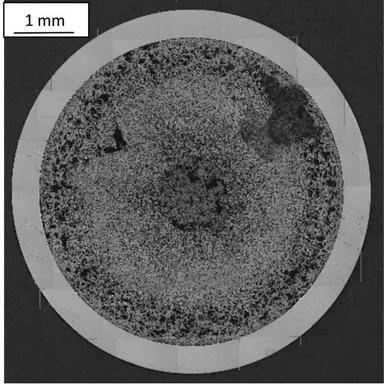
X501-G591 cross section optical image at x/L ¼ 0.95, local burnup 4.49% FIMA.